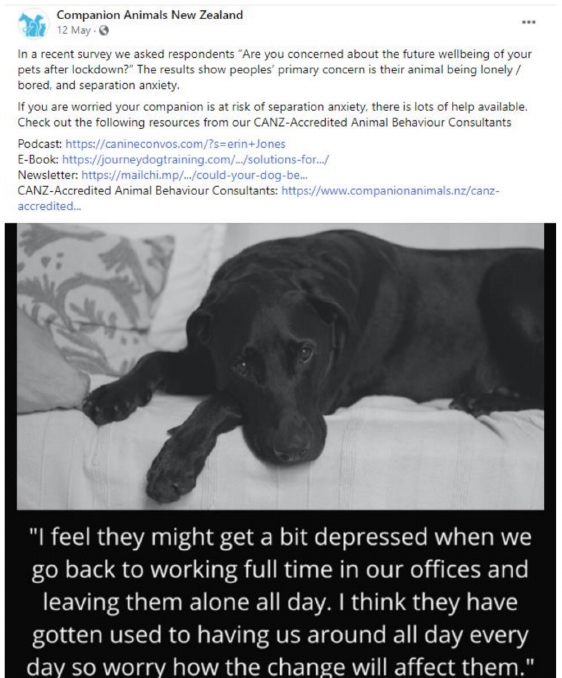
Figure 2. An example of a Facebook post by Companion Animals New Zealand addressing a common concern regarding post-lockdown among pet owners and providing links to appropriate